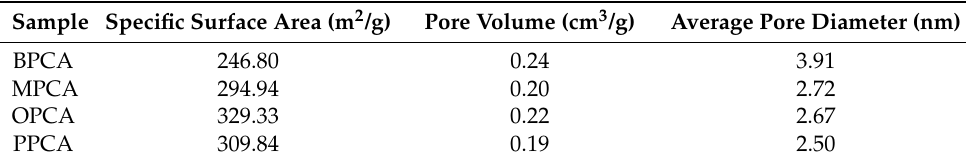
Table 2. Pore structures of CAs prepared from different waste biomasses.